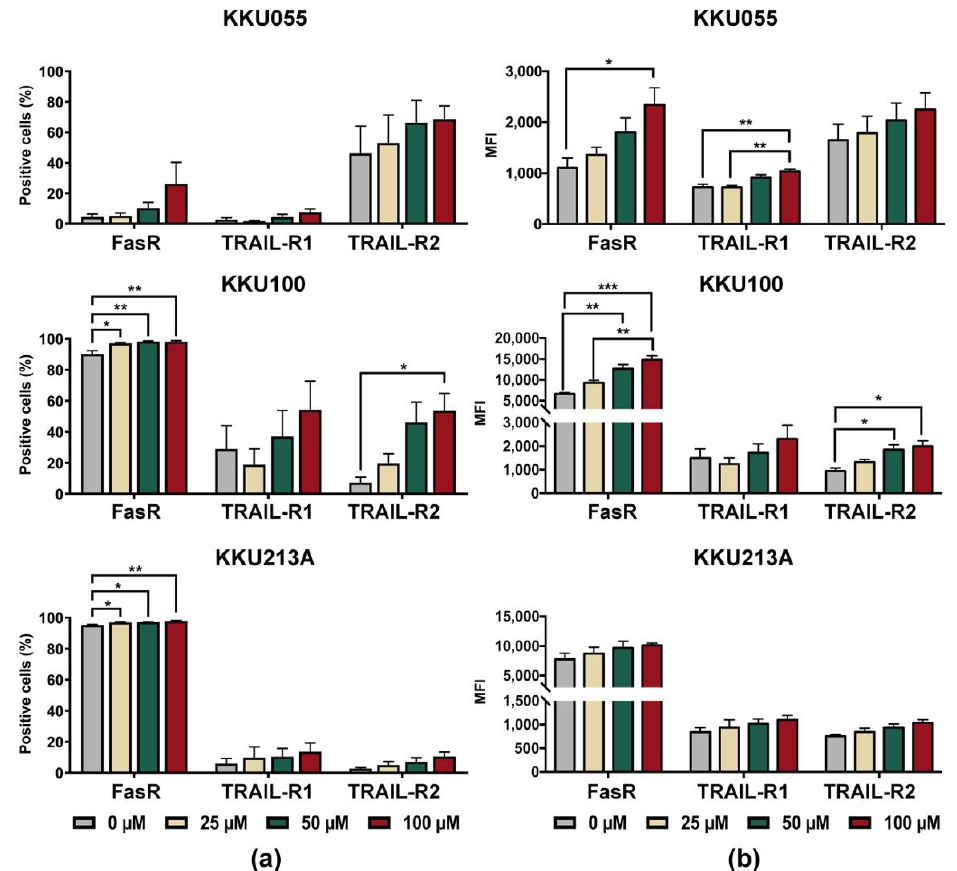
Figure 6. Changes of cell surface expression levels of death receptors after treatment of KKU055, KKU100, and KKU213A cells with genistein, analyzed by flow cytometry. The cell surface expression of FasR (CD95), TRAIL-R1 (DR4), and TRAIL-R2 (DR5) were analyzed after treatment of CCA cells with genistein for 24 h. ( a ) Percentage of positive cells, and ( b ) mean fluorescent intensities (MFI) were quantified, compared to that of the diluent control. The statistical analyses were performed to compare between the results of treated condition and that of the diluent control (* indicates p < 0.05, ** indicates p < 0.01, and *** indicates p <